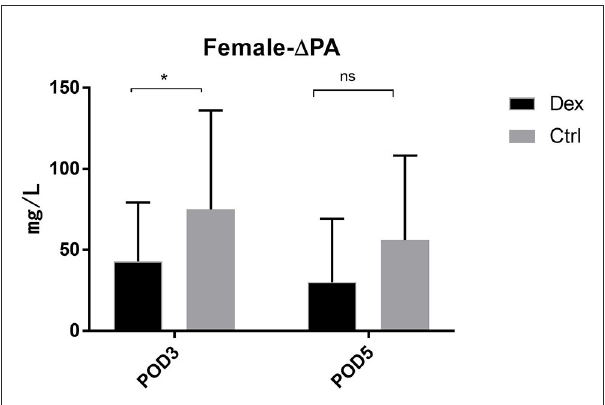
FIGURE6 The decrease of PA in POD3 and POD5 in female patients. 1 represents the difference between preoperative value and postoperative value. ns P > 0.05, * P < 0.05.